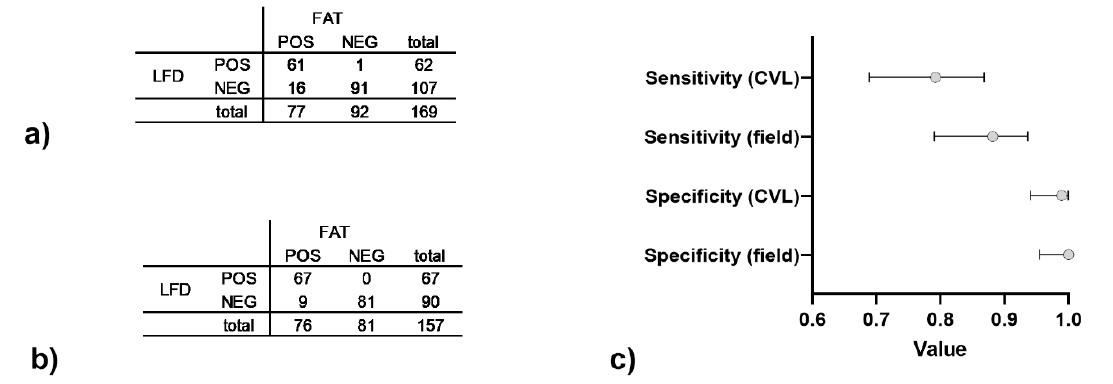
Figure 2. Data for Anigen/Bionote LFD performance in comparison with FAT for samples arriving at CVL ( a ) and samples from the field ( b ) between 2019–2021. The resulting sensitivity and sensitivity are shown ( c ) with 95% confidence intervals indicated.